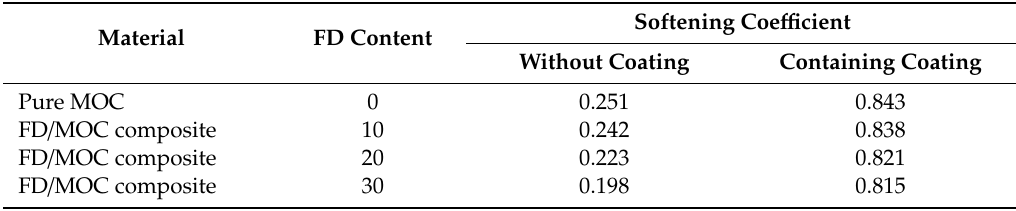
Figure 9. Compressive strength measurement of the FD / MOC composites. ( a ) FD / MOC composites without coating before soaking in water; ( b ) FD / MOC composites without coating after soaking in water; ( c ) FD / MOC composites containing coating before soaking in water; ( d ) FD / MOC composites containing coating after soaking in water. Table 4. Softening coe ffi cient measurement for the FD / MOC composites before and after superhydrophobic coating treatment.